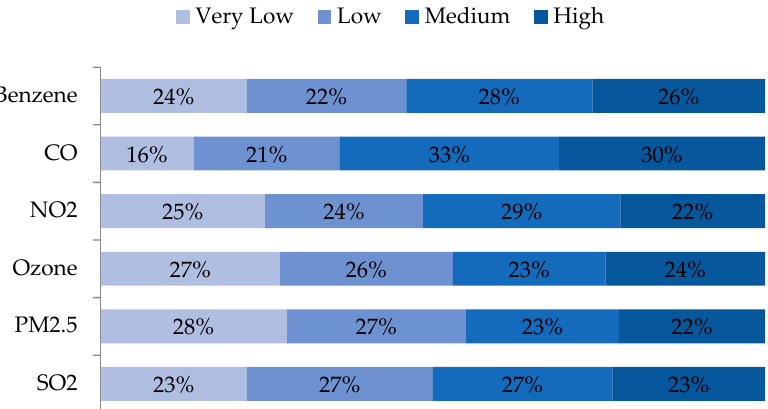
Figure 10. Distribution of exposure category based on WA metrics, for all observations with ambient air measurements indicating ‘High’ exposure, by pollutant.